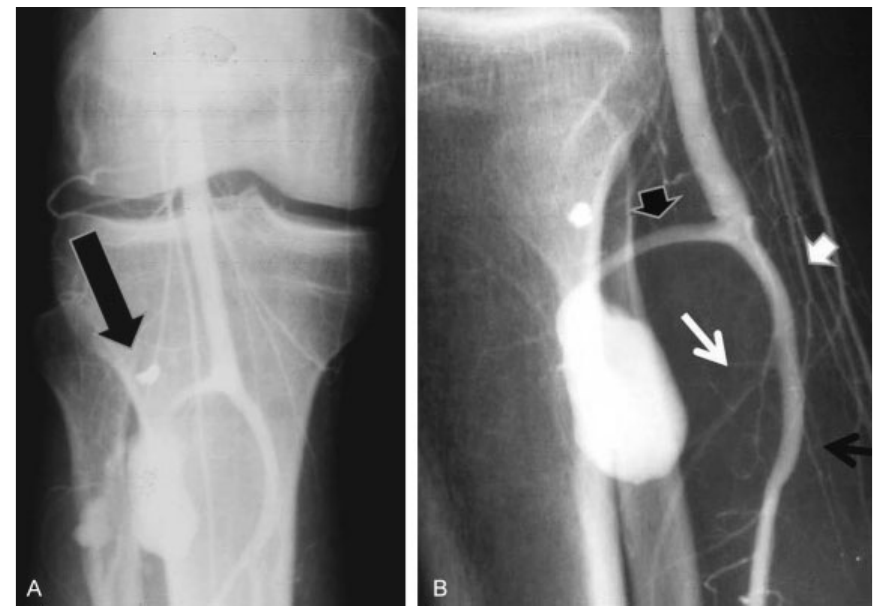
Fig. 1 ( A , B ) 0, AP and lateral femoral artery angiography show the pseudoaneurysm arising from proximal anterior tibial artery in popliteal region (black arrow head).The tibioperoneal trunk is patent (white arrow head). The posterior tibial artery (black arrow) is demonstrated where peroneal artery (whitearrow seems to be narrow probably because of thecompressive effectof the pseudoaneurysm. A small missilefragment is demonstrated in both views (short black